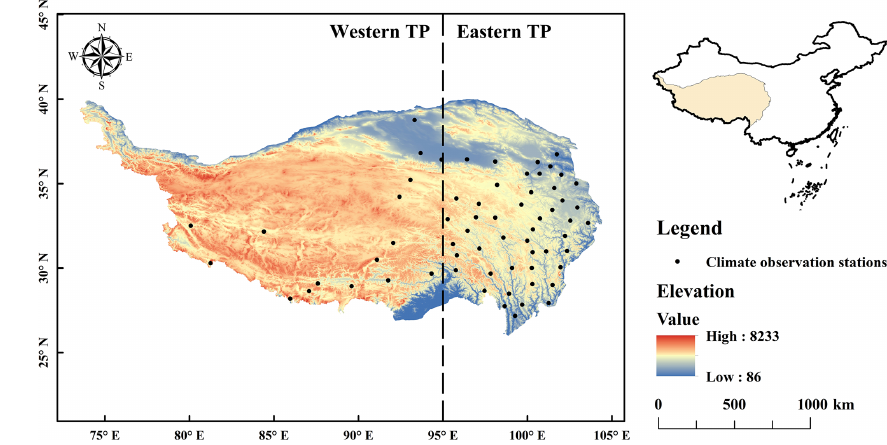
Figure 1. The location and elevation of the Tibetan Plateau (TP) and the location of climate observation